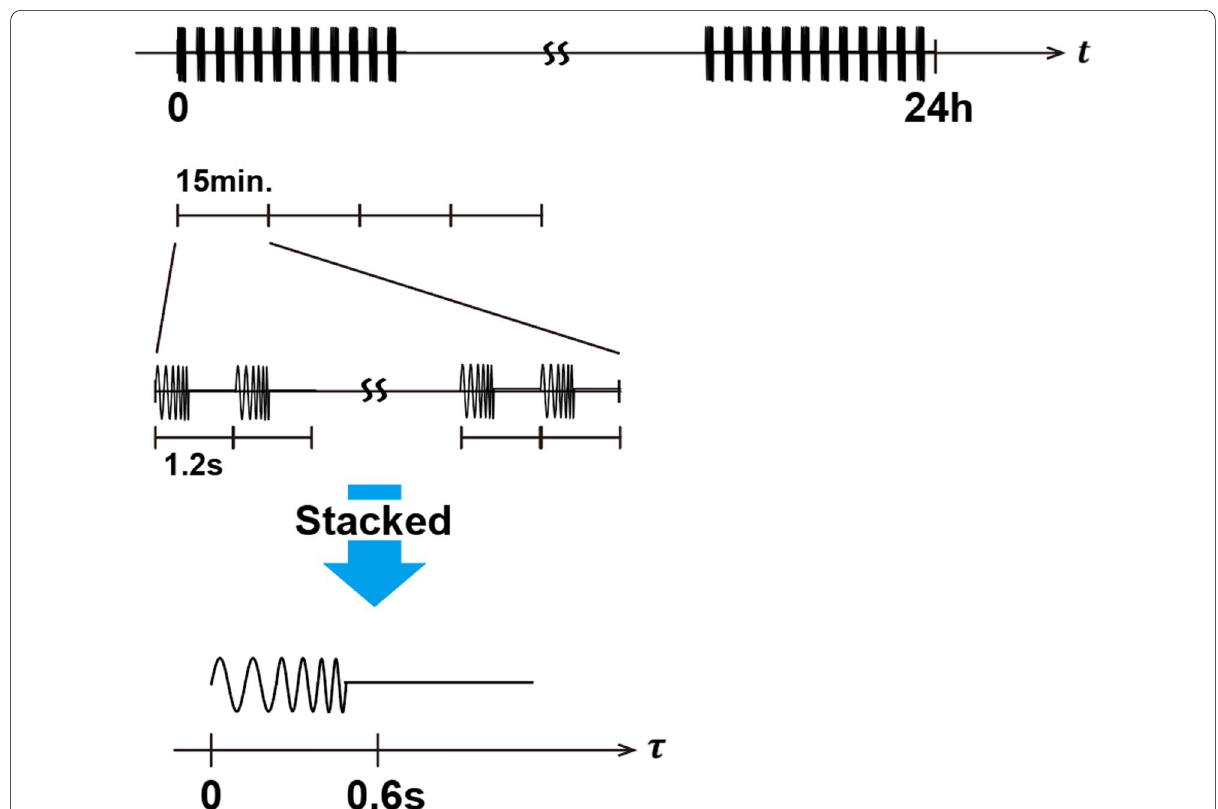
Fig. 3 Schematic illustration of wave stacking in our